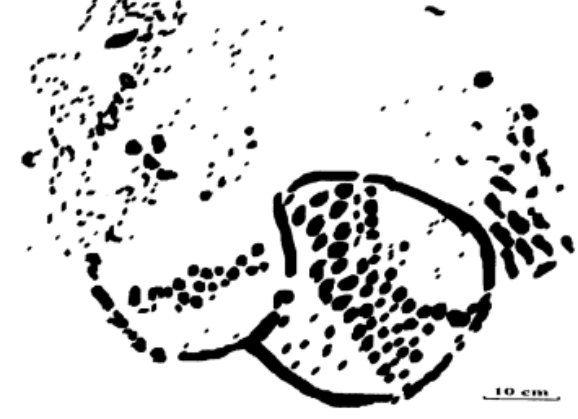
Figure 9 . Zaouiat Sidi Abdenbi. Dots and curvilinear designs (from Nami et al, 2007). Figure 9. Zaouiat Sidi Abdenbi. Dots and curvilinear designs (from Nami et al,